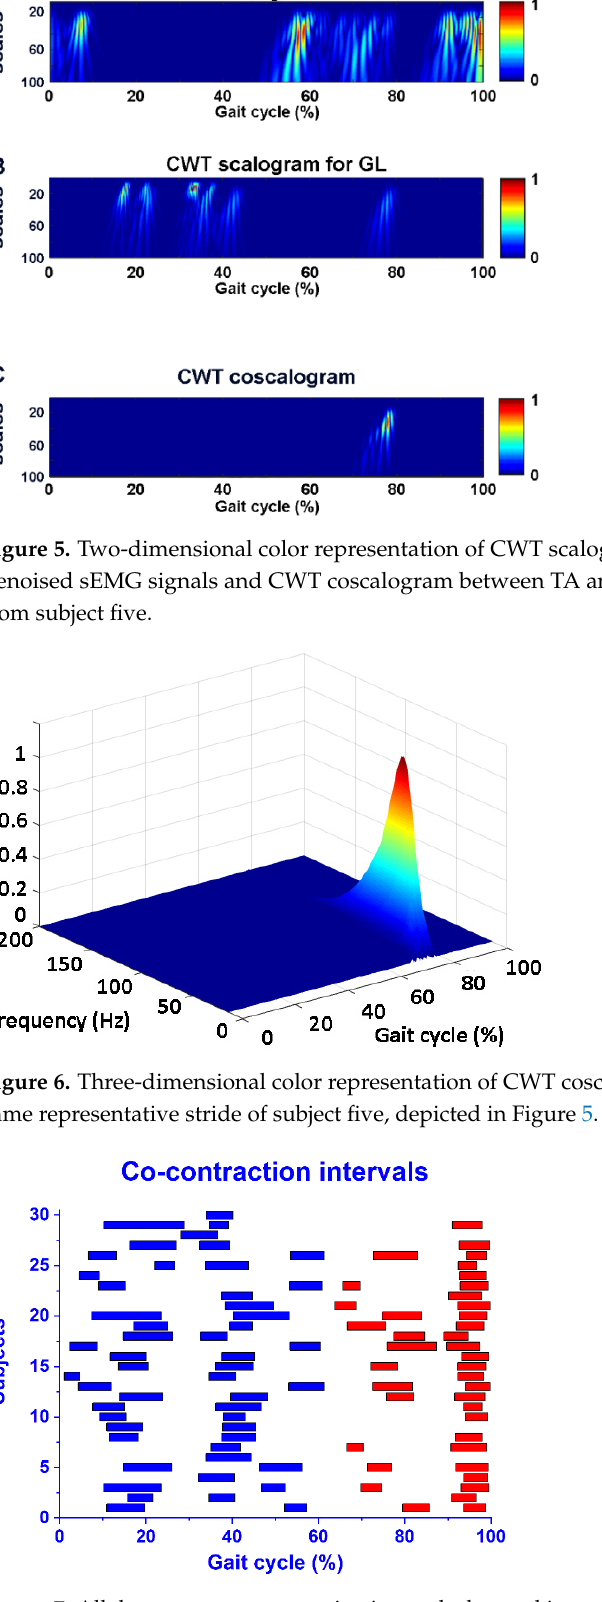
Figure 7. All the average co-contraction intervals detected in stance (blue bars) and in swing (red bars) in each one of the thirty subjects of the population. Values are expressed in percentage of gait cycle.